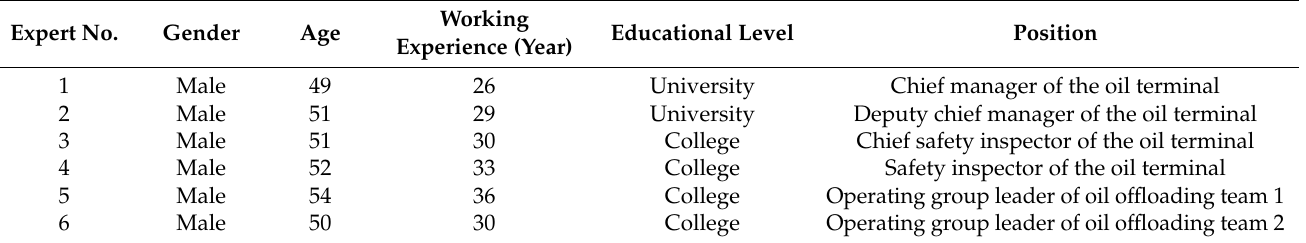
Table 5. The information of each invited